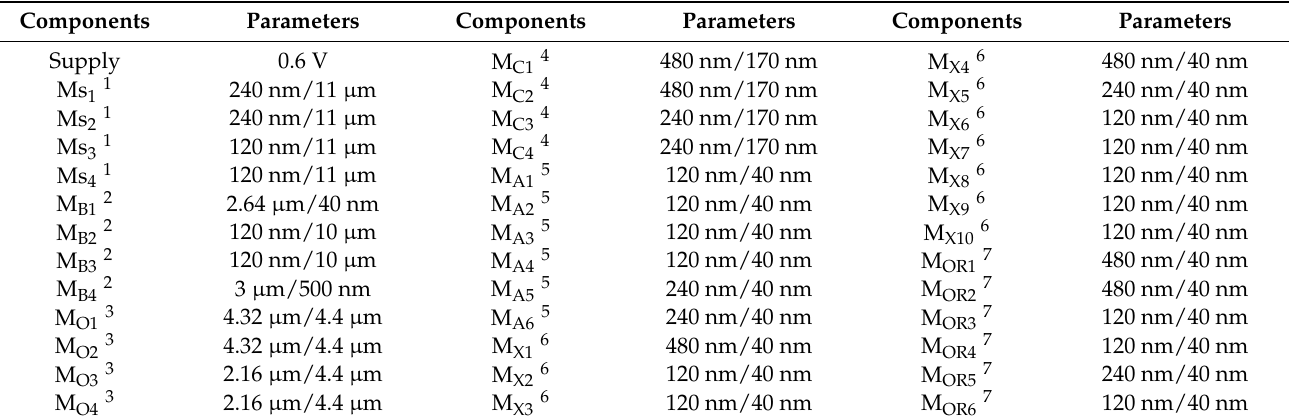
Table A1. Design parameters used in this